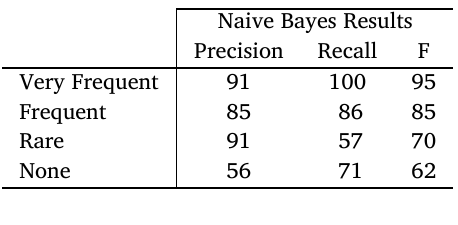
Confusion Matrix of token-based Naive Bayes classifier for Cinque’s